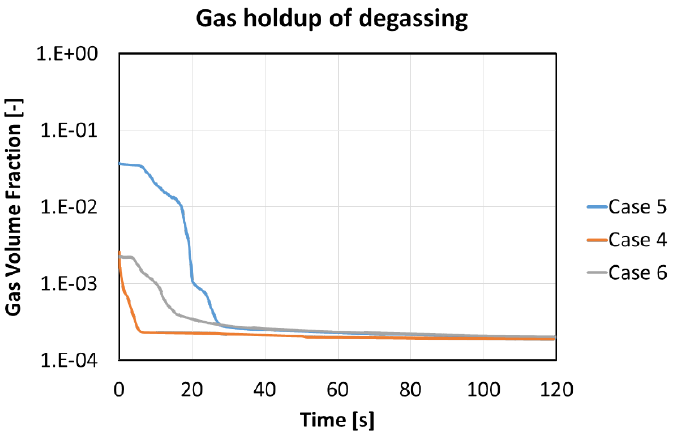
Figure 10. Gas holdups in logarithmic scale during 120 s degassing for different flow rates and